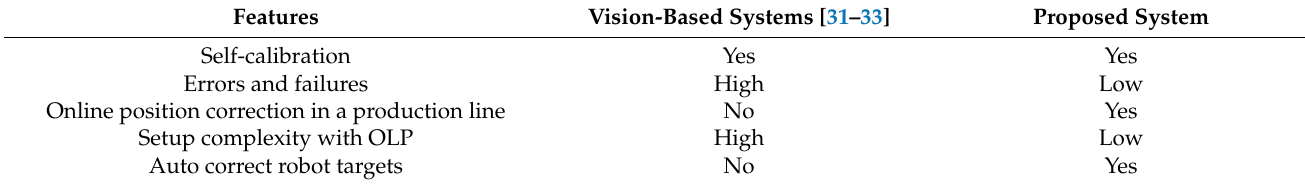
Table 1. Comparison between existing vision-based position correction systems and the proposed system.